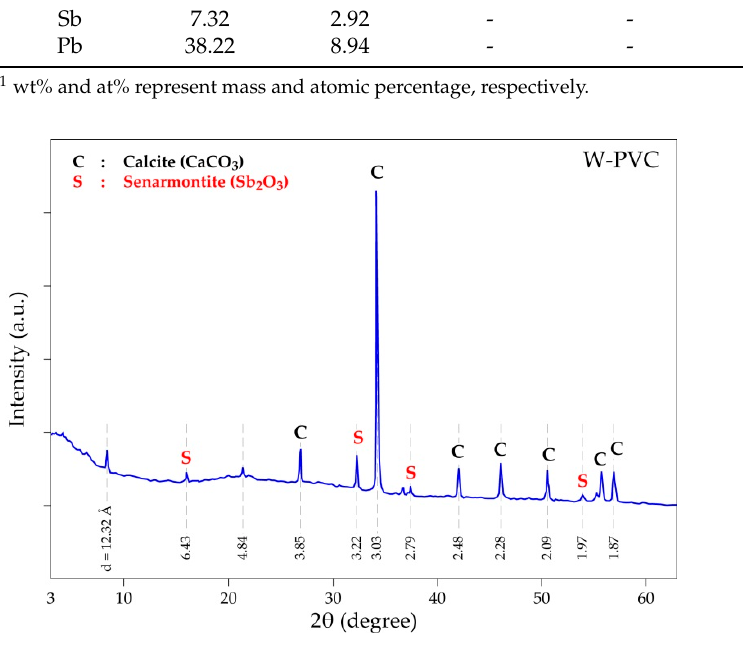
Figure 4. XRD diffractogram of the W-PVC sample.